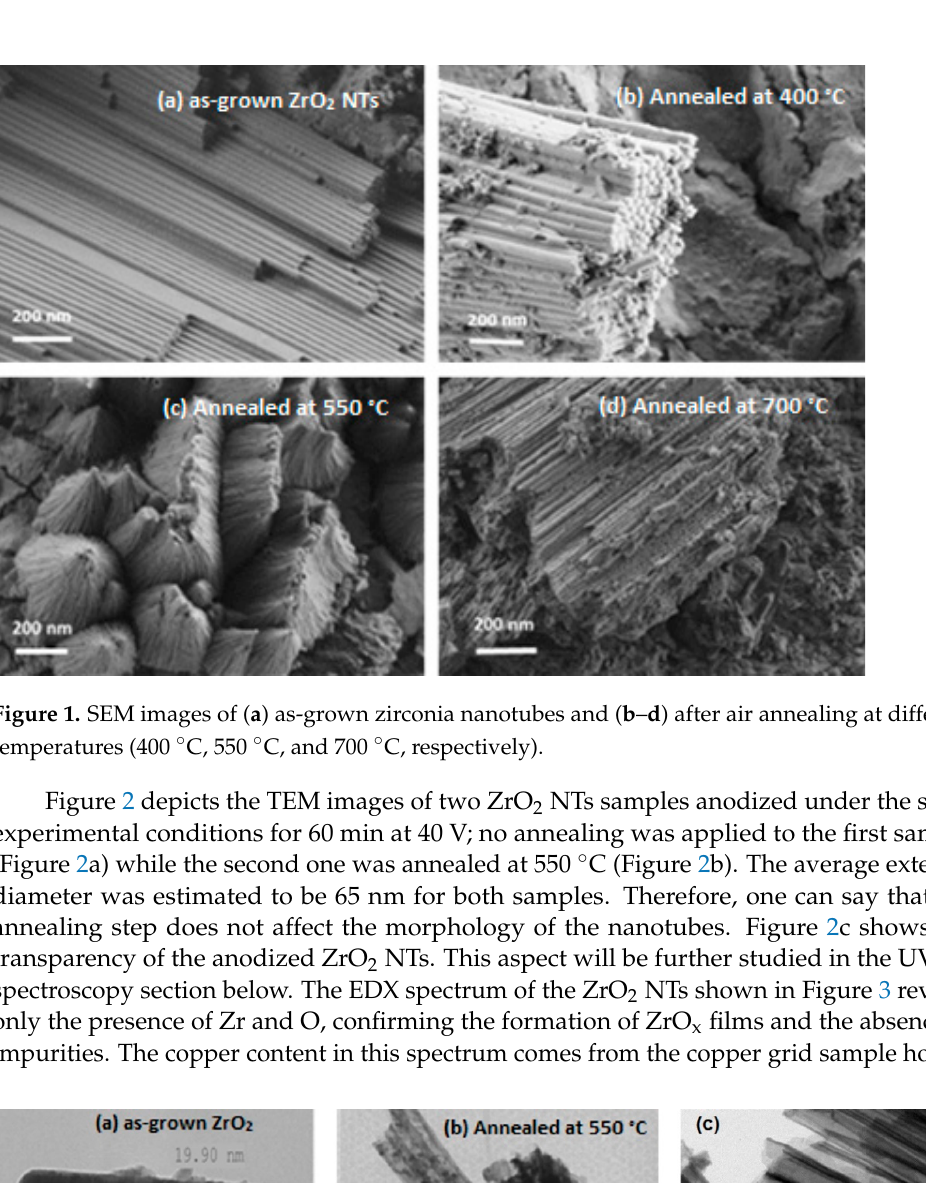
Figure 1. SEM images of ( a ) as-grown zirconia nanotubes and ( b – d ) after air annealing at different temperatures (400 °C, 550 °C, and 700 °C, respectively). Figure 2. TEM images of the ZrO 2 nanotubes: ( a ) as-grown, ( b ) annealed at 550 °C in air, and ( c ) transparency of ZrO 2 nanotubes annealed at 550 °C.